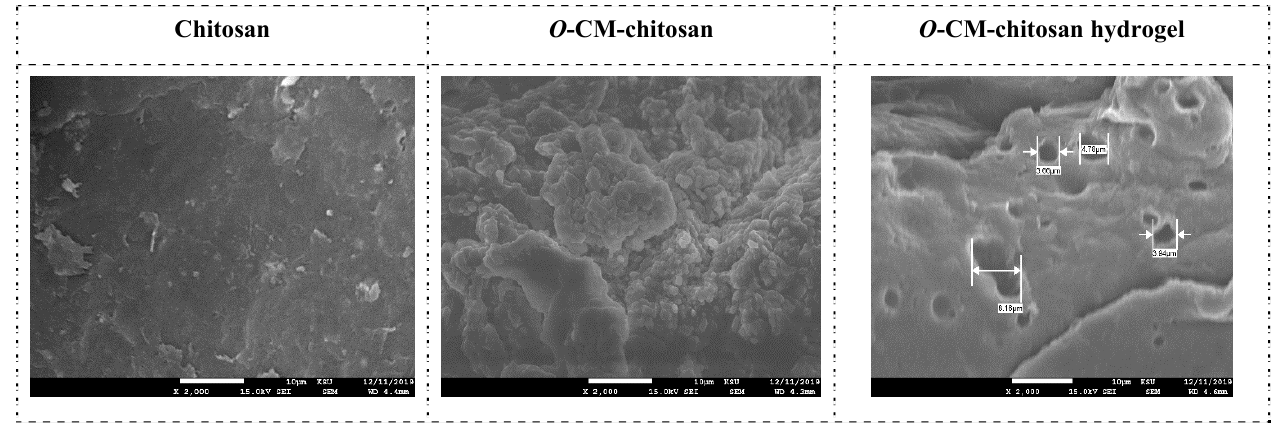
Figure 5. SEM micrographs of chitosan, O -CM-chitosan and the O -CM-chitosan hydrogel.